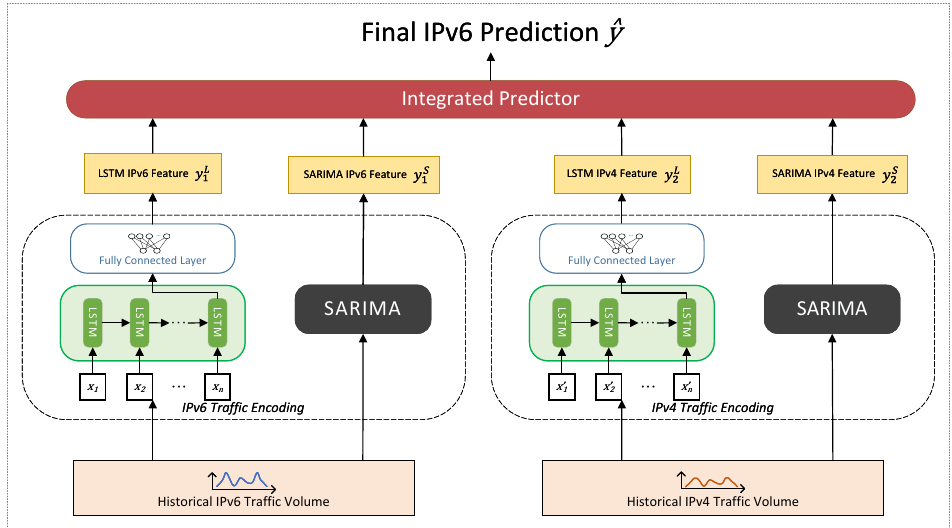
Figure 5. System design of